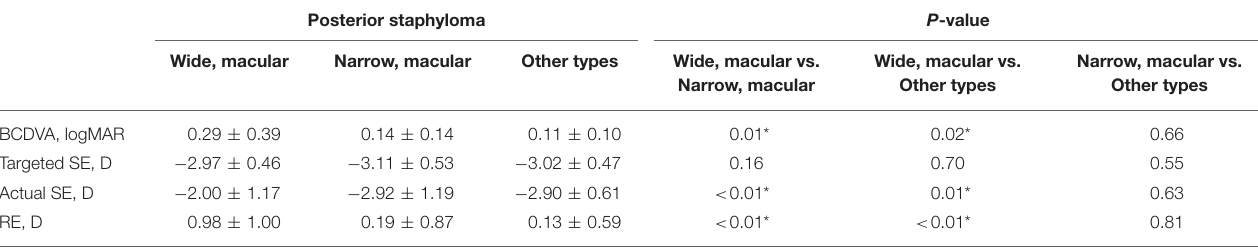
TABLE 2 | Postoperative refractive characteristics of patients with highly myopic eyes and posterior staphyloma.